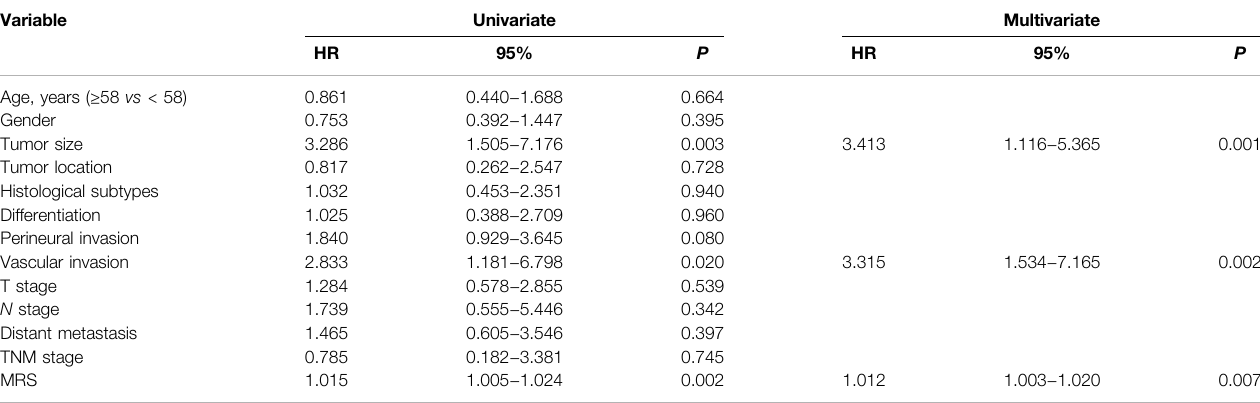
TABLE 3 | Univariate and multivariate analysis of factors associated with TTR according to the Cox Proportional Hazards Model. Variable Univariate